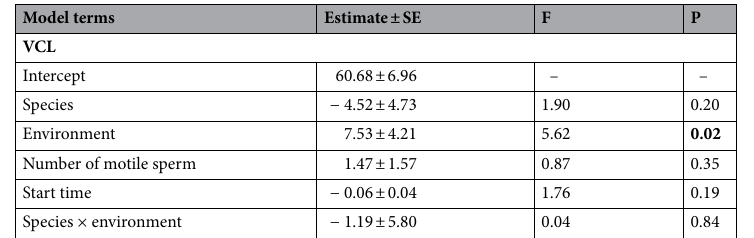
Table 3. The linear mixed model testing for the effect of the species identity, environment (female fluid vs. PBS) and their interaction on sperm velocity (VCL). The number of motile sperm and starting time of the particular recording in sec were included in the model as covariates. The common nightingale species and female fluid environment were set as a reference. The estimates, standard errors (± SE), F-stats and P-values are shown, with significant P-values in